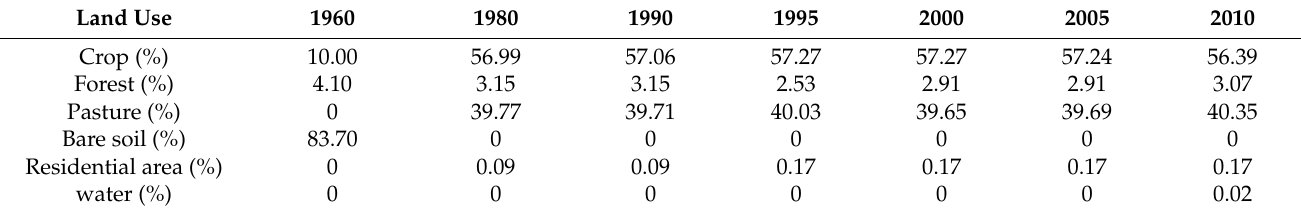
Table 4. Proportions of major land-use types in the Chabagou River Watershed in 1960, 1980, 1990,